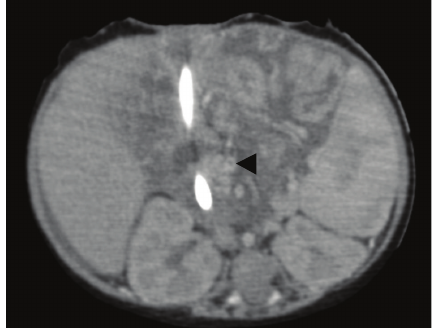
Figure 1: Clot in SMV seen as filling defect with halo of contrast at arrow head.